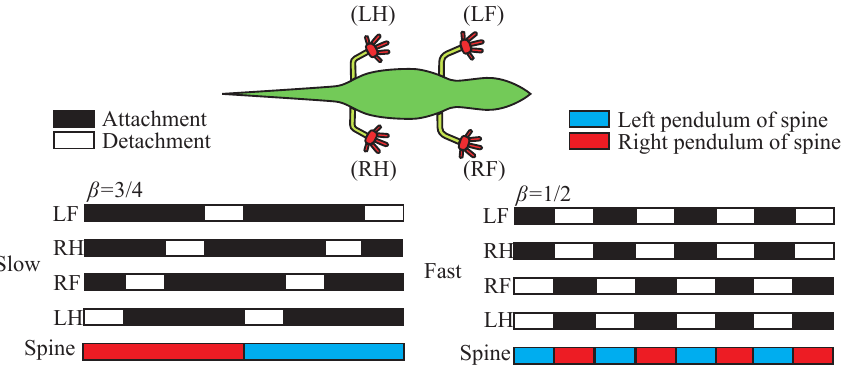
Figure 10. Motion–gait phase relationship of the anole lizard-inspired climbing robot; β is the ratio of adhesion time to the sum of adhesion and detachment time.